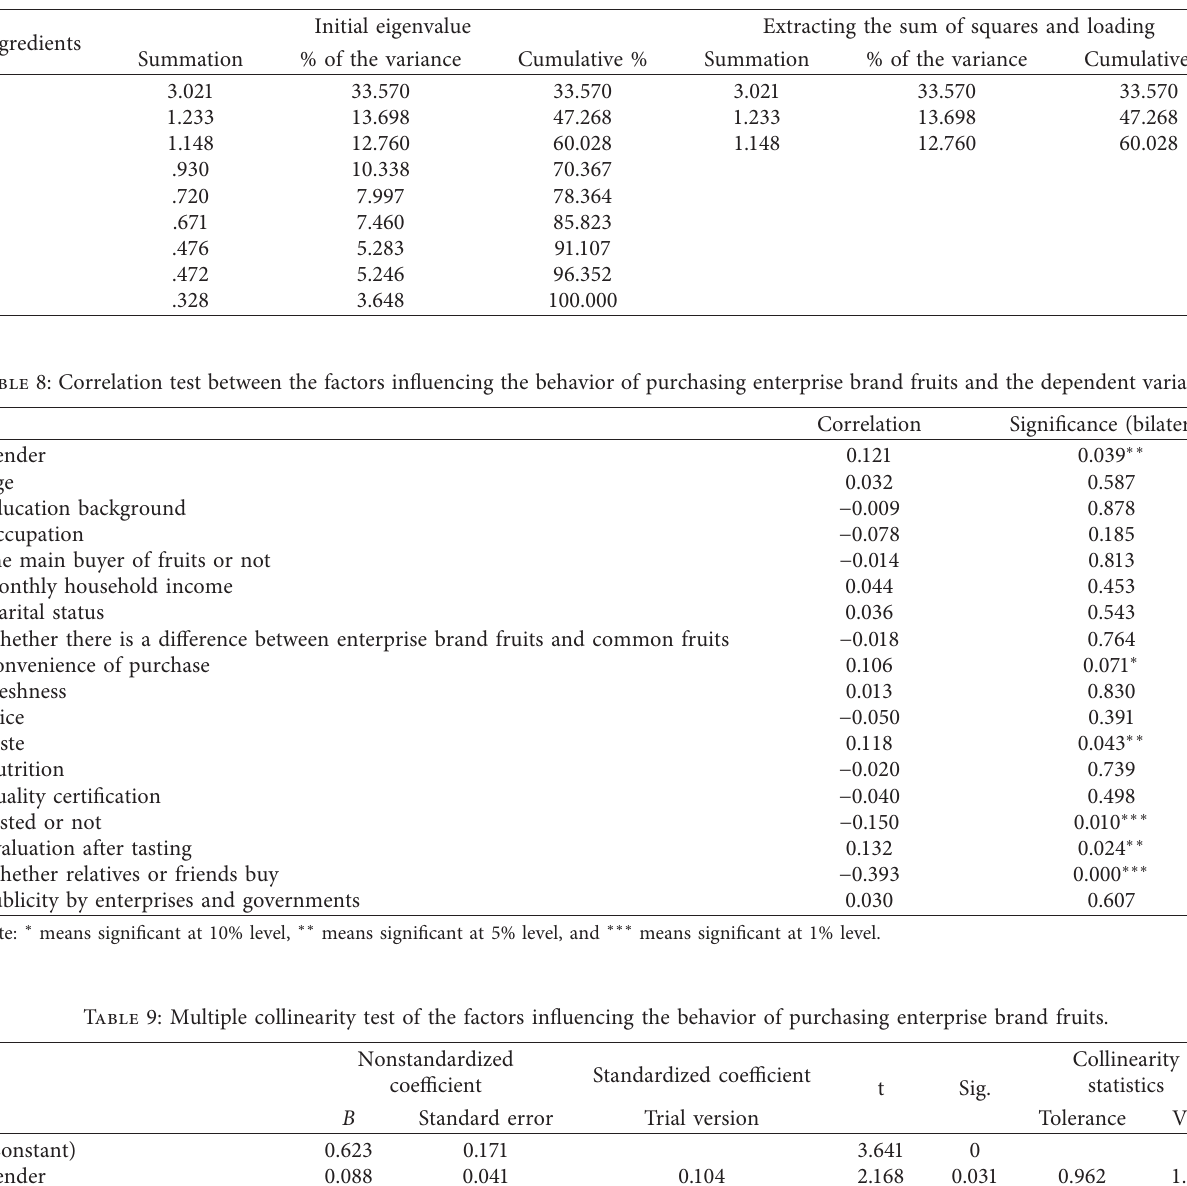
Table 7: Explanation of the total variance.